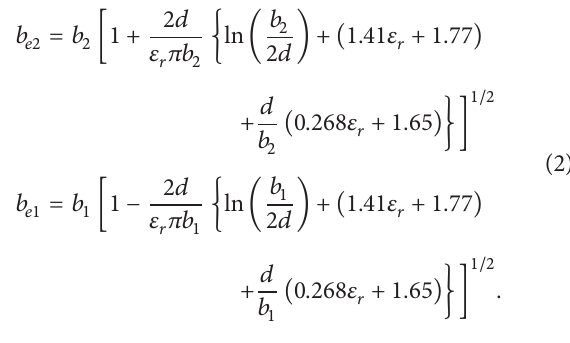
For the annular ellipse shape patch the effective semi- minor of the outer and inner axis is given by